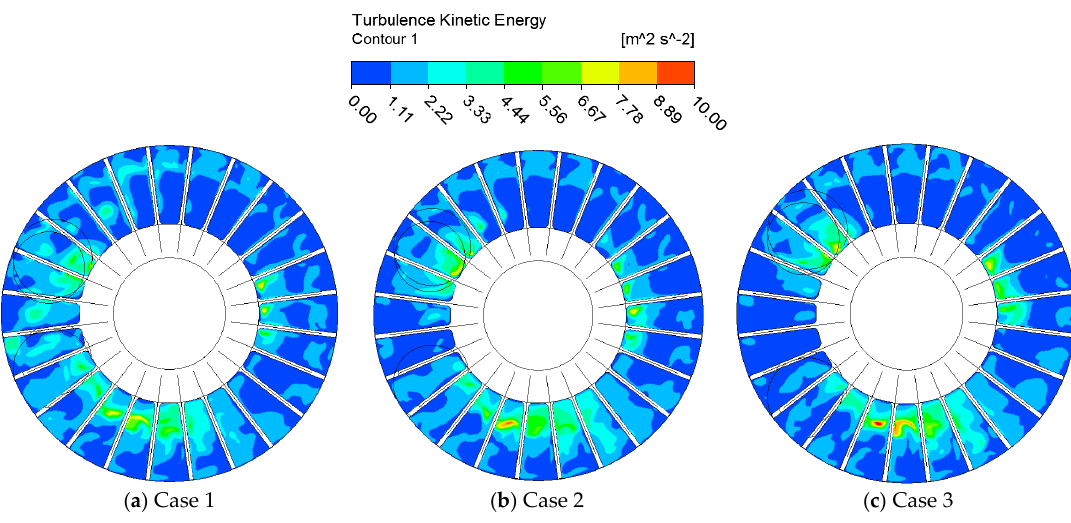
Figure 24. Turbulent kinetic energy intensity in impeller passage.